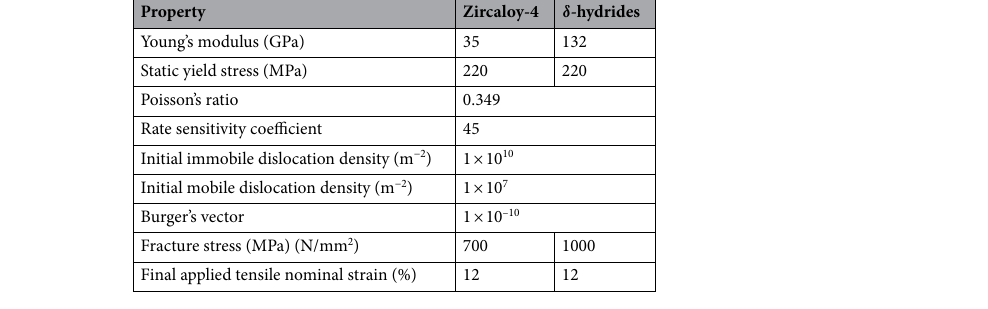
Table 2. Material properties.